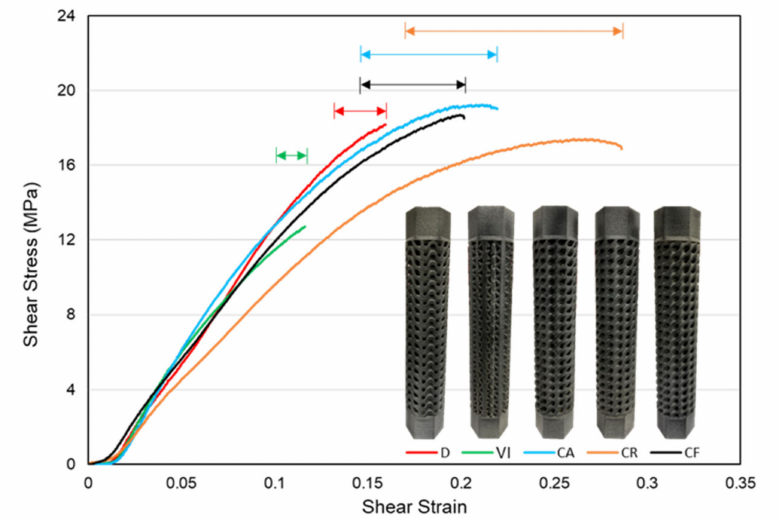
Figure 17. Approximate plastic deformation regions based on stress-strain curves of structures.